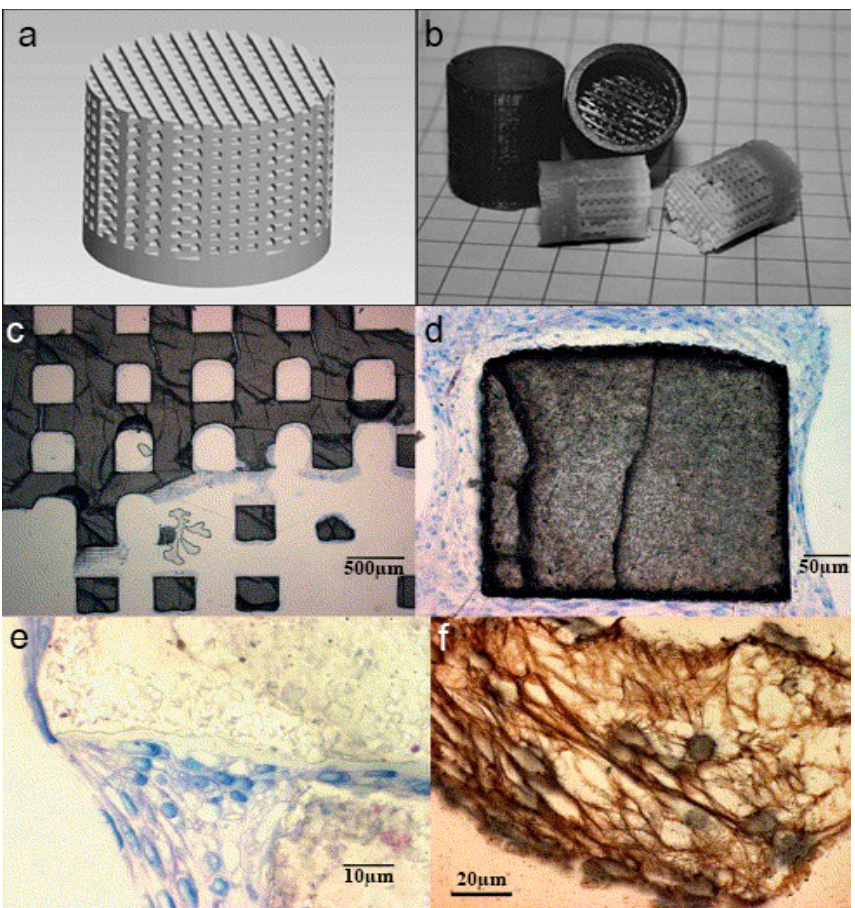
Figure 9. ( a ) Computer aided design (CAD) designed virtual structure of casting mold; ( b ) Resin casting molds manufactured by stereolithography and sintered hydroxyapatite (HA) structures; ( c ) SEM image of HA scaffold after culturing with MC3T3-E1 cells for 2 weeks, scaffold is visible in (dark grey) and cells (blue); ( d ) SEM image of strut of HA scaffold (grey), entirely attached with cells (blue/pink); ( e ) SEM image of microstructure of a crack between two struts, which was totally covered by MC3T3 cells (blue) and matrix created by the cells(pink); ( f ) SEM images of collagen produced by the cells (the microtome sectioning eliminates the mineral scaffold) [80].